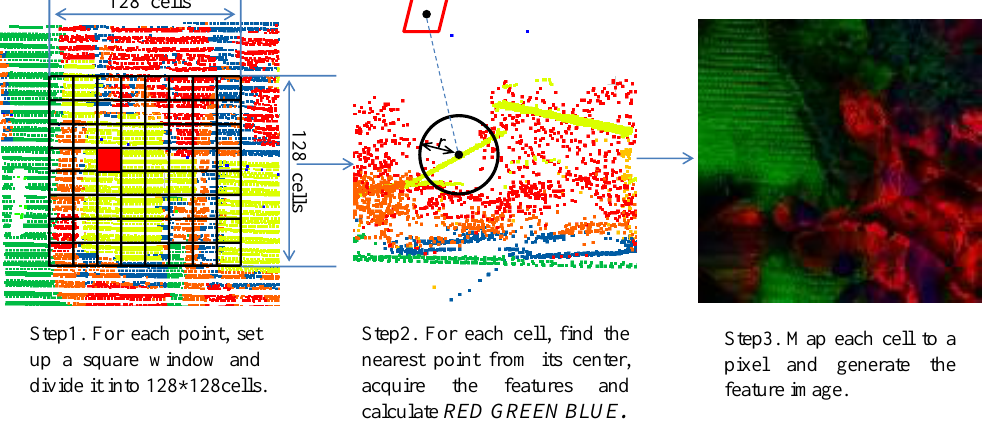
Figure 3. Steps of the feature image generation.